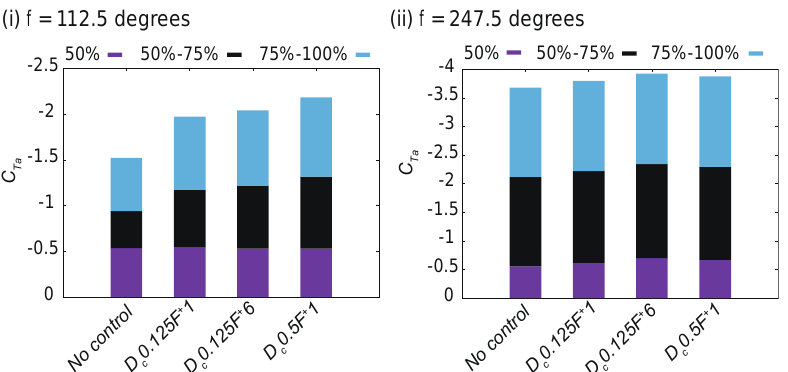
Figure 8. Contributions of phase-averaged axial torque coefficients along the span of the blade.